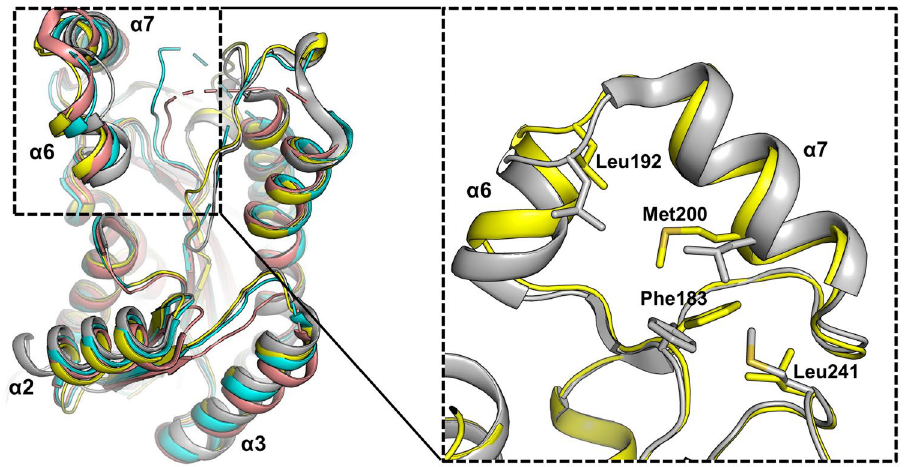
Figure 3. Structures of AbFabG (yellow), E. coli EcFabG (cyan, PDB ID: 1I01), P. aeruginosa PaFabG (gray, PDB ID: 4AFN), and V. cholerae VcFabG (salmon, PDB ID: 5END) are superposed. In the blown-up view, oriented in the same viewpoint as in Fig. 2c, AbFabG (yellow) and PaFabG (gray) are used to illustrate the residues (stick models) that are compared in the text.